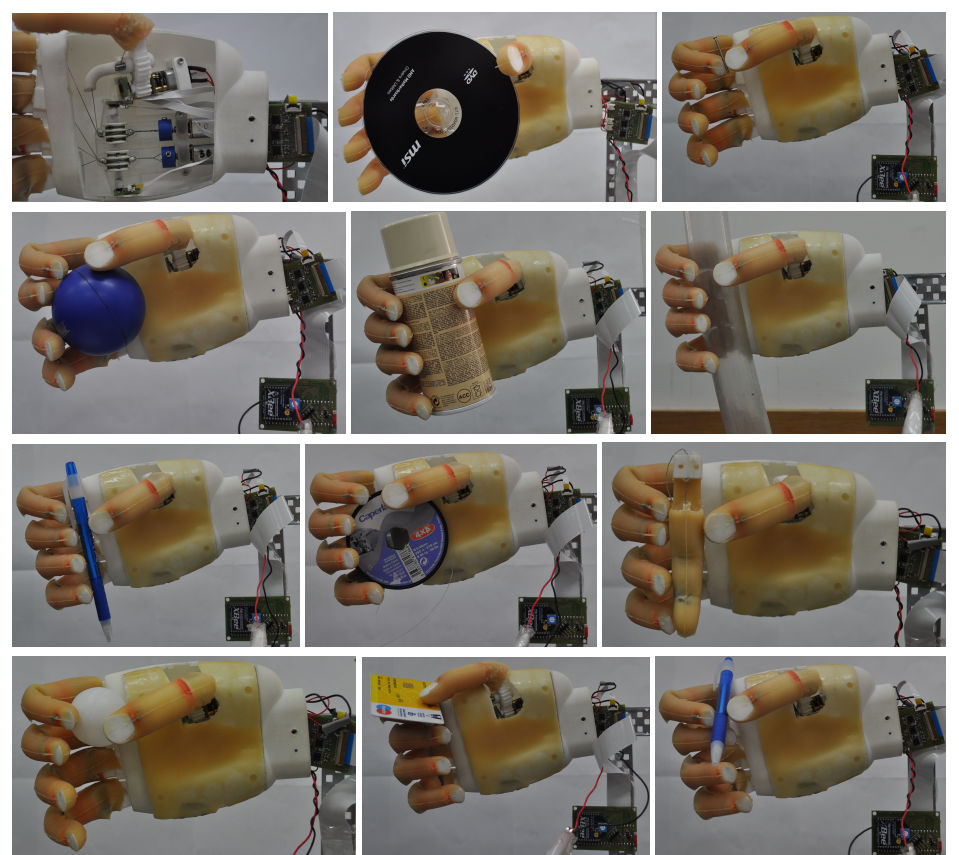
Figure 13. Prototype of the UC-Softhand and achieving several precision and power grasps. The hand is able to grasp objects as large as a CD. Since the thumb and the index finger are operated with a single actuator, the tendon’s slack is adjusted in a way that the tip of both fingers can achieve a precision grasp, such as grasping a tiny screw. The thumb’s rotation enables lateral pinch grasp such as grasping a credit card.